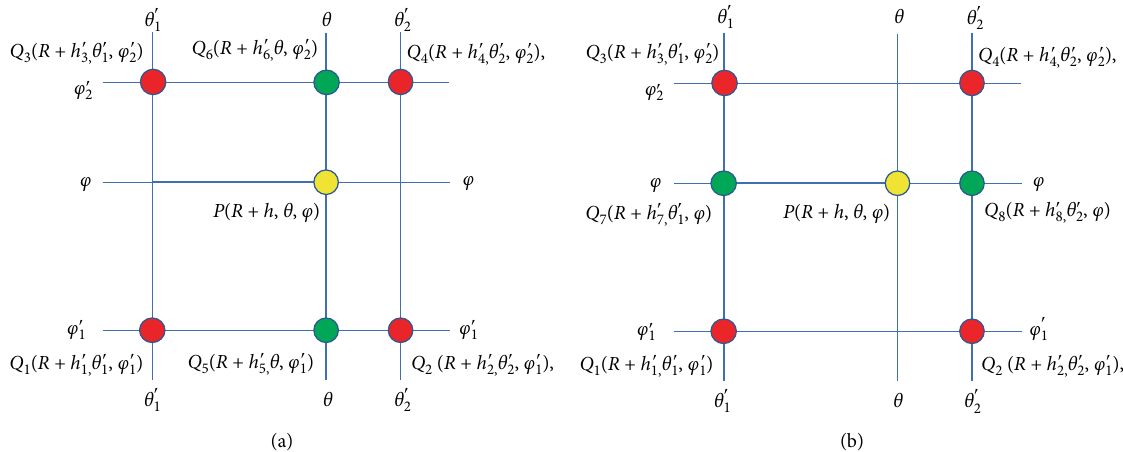
Figure 16: Schematic diagram for the derivation process of Formula (19). (a) Add two green points 𝑄 equivalent to 𝜃 . (b) Add two green points 𝑄